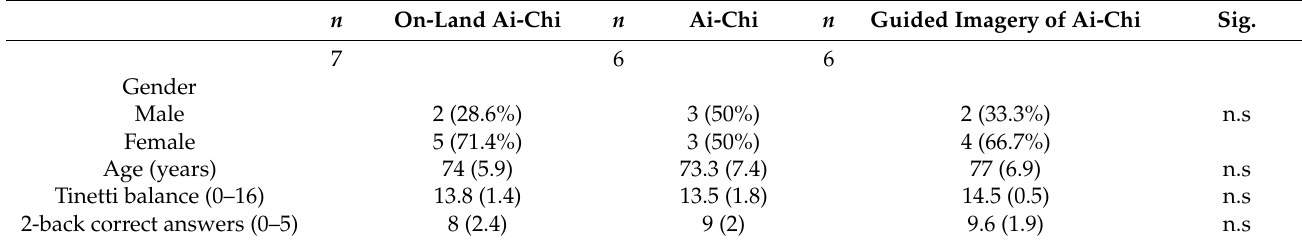
Table 1. Participants’ demographic variables across intervention groups and experimental parameters measured between groups at the beginning.